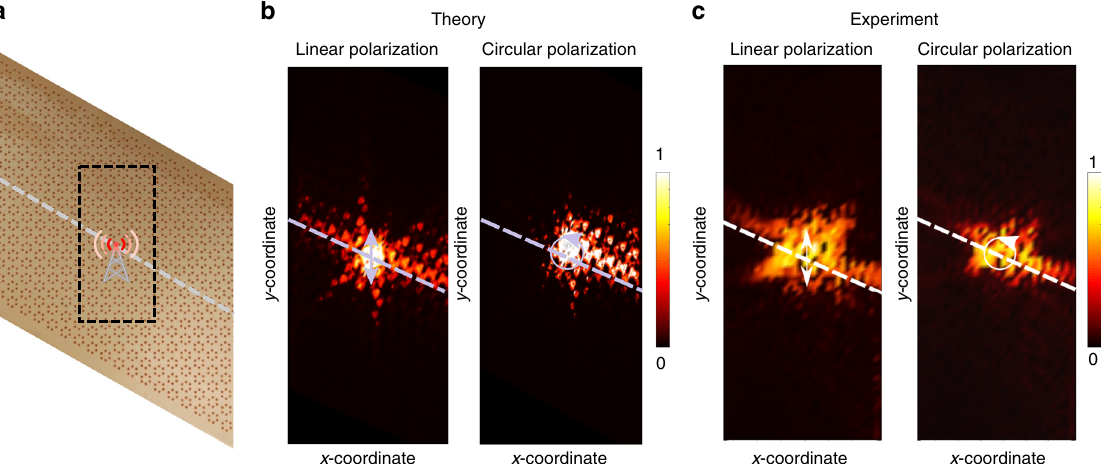
Fig. 5 Proof-of-concept experiment observation of pseudo-spin polarized edge states in microwaves. a Photograph of fabricated metasurface. The gray dashed line indicates the position of the domain wall and the black dashed rectangle shows the spatial xy range of near- fi eld scanning shown in b , c . The antenna indicates the position of the dipole source. b Numerically calculated near- fi eld of the edge states excited by linearly and circularly polarized dipoles. c Color map of the measured near- fi eld of the edge states at the frequency f = 6.84 GHz for the linearly and circularly polarized excitations. The unidirectional excitation by the circularly polarized fi eld con fi rms pseudo-spin locking of the edge are r = 1.5 mm and h = 10 mm, respectively. The cluster size R (Fig. 1a, b) was chosen such that a / R = 3.33 and a / R = 2.73 for shrunken and expanded structures, respectively. For these parameters, the bandgap is characterized by the mid-gap frequency of 6.79 GHz with a total bandwidth of 310 MHz.